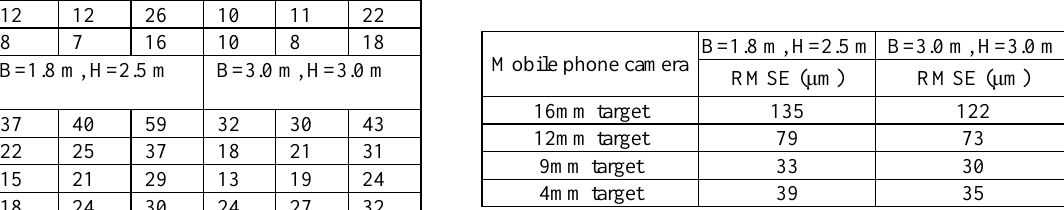
Table 5: Coordinate standard deviations under the different configurations.